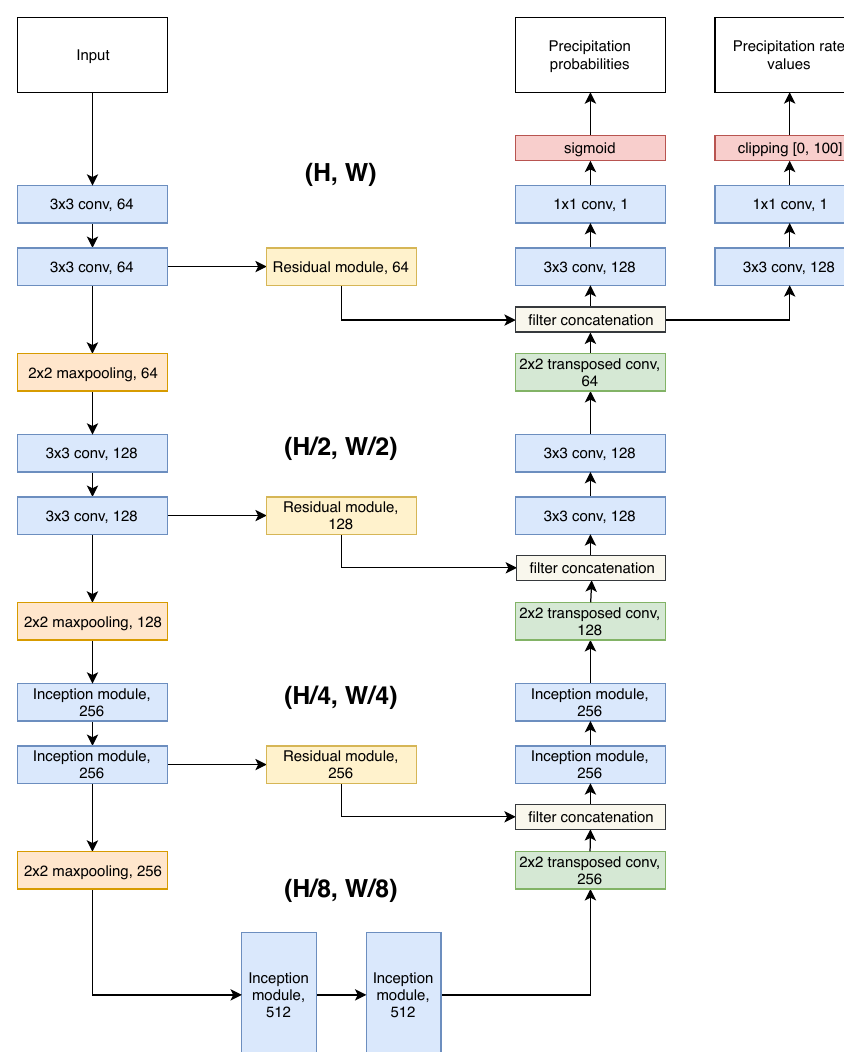
Figure 5. Diagram of the proposed model architecture. Each convolutional layer is followed by a batch-normalization layer [22] and the ReLU activation function, except for the last 1 × 1 convolutional layers of each sub-networks. The output of the residual modules and the transposed convolutions are concatenated before being fed to the next layer.